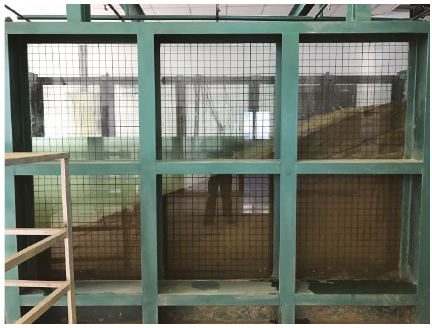
Figure 6: Initial water